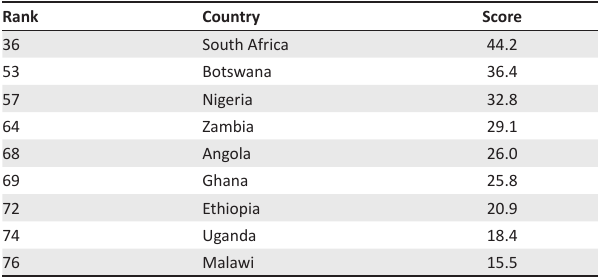
TABLE 1: Sub-Saharan Africa